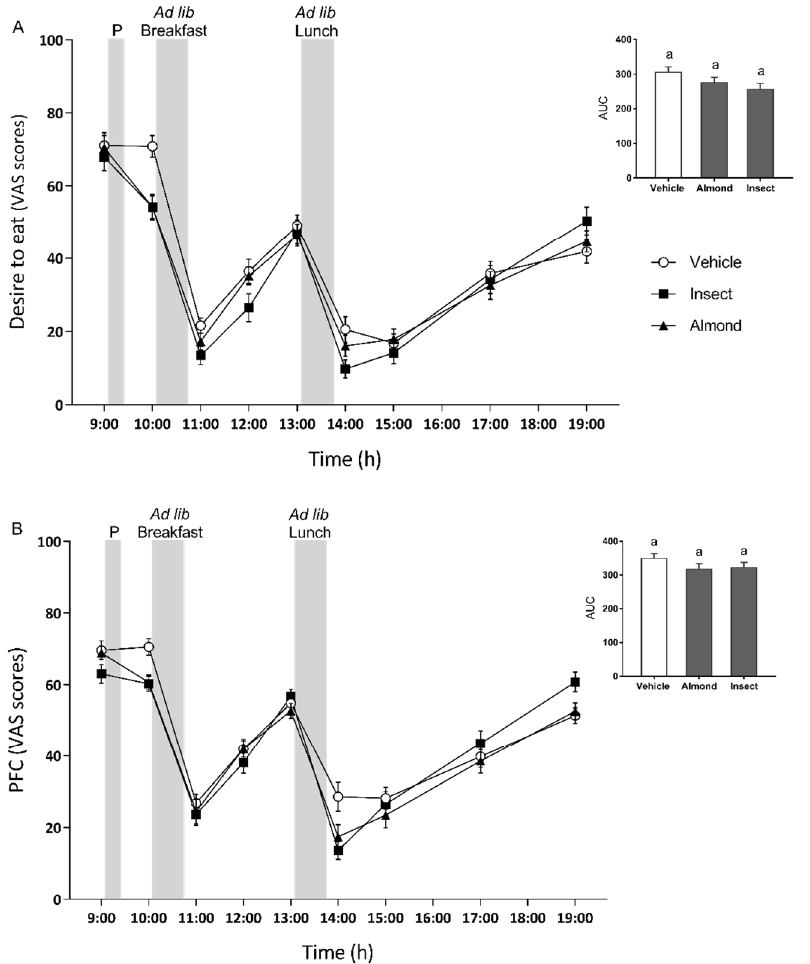
Figure 4. Desire to eat ( A ) and prospective food consumption ( B ) ratings during the three test days. Grey bars indicate the times of the preload (P), breakfast and lunch intake. Participants were asked to complete VAS questionnaires to rate their motivation to eat five minutes before P and at the subsequent time points indicated in the graph. Data are expressed as mean ± standard error of the mean (SEM). The bar graph represents the mean AUC of each of the three preload groups for both variables. Same letters (a) indicate no significant differences, p > 0.05 (repeated-measures ANOVA followed by Bonferroni adjustment for multiple comparisons).